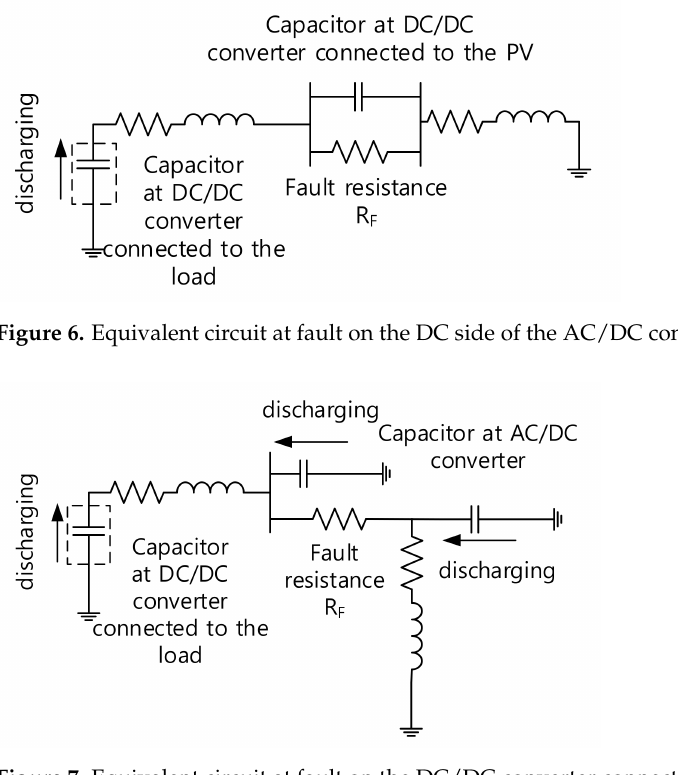
Figure 7. Equivalent circuit at fault on the DC/DC converter connected to